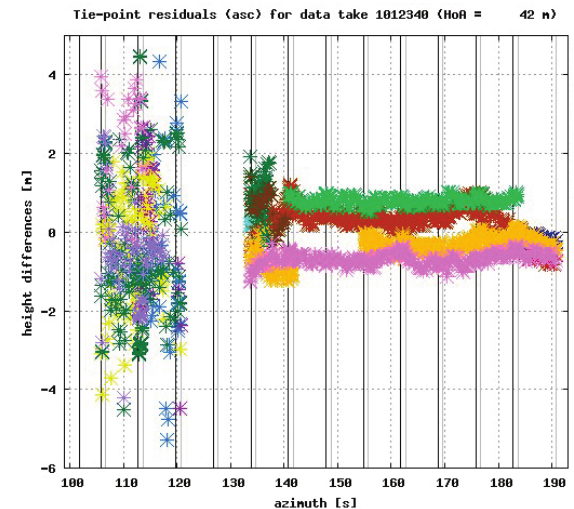
Figure 5. Tie-points starting from rock towards percolation zone of datatake 1012340: Differences master datatake – neighboring datatakes: one color for each datatake